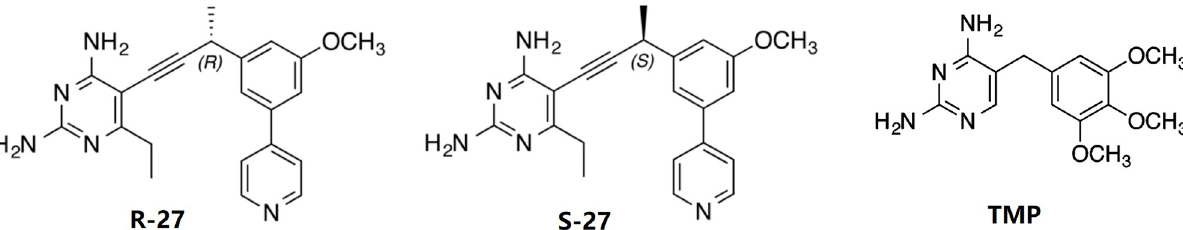
Fig 1. Chemical structures of R-27, S-27, and trimethoprim (TMP). The linear triple-bond linker of both R-27 and S-27 limits steric clashes within the binding pocket, and the biaryl ring system mimics the para-aminobenzoic acid (PABA) and glutamate moieties of folate [12, 15]. The chiral center of R-27 and S-27 is labeled with (R) and (S) ,